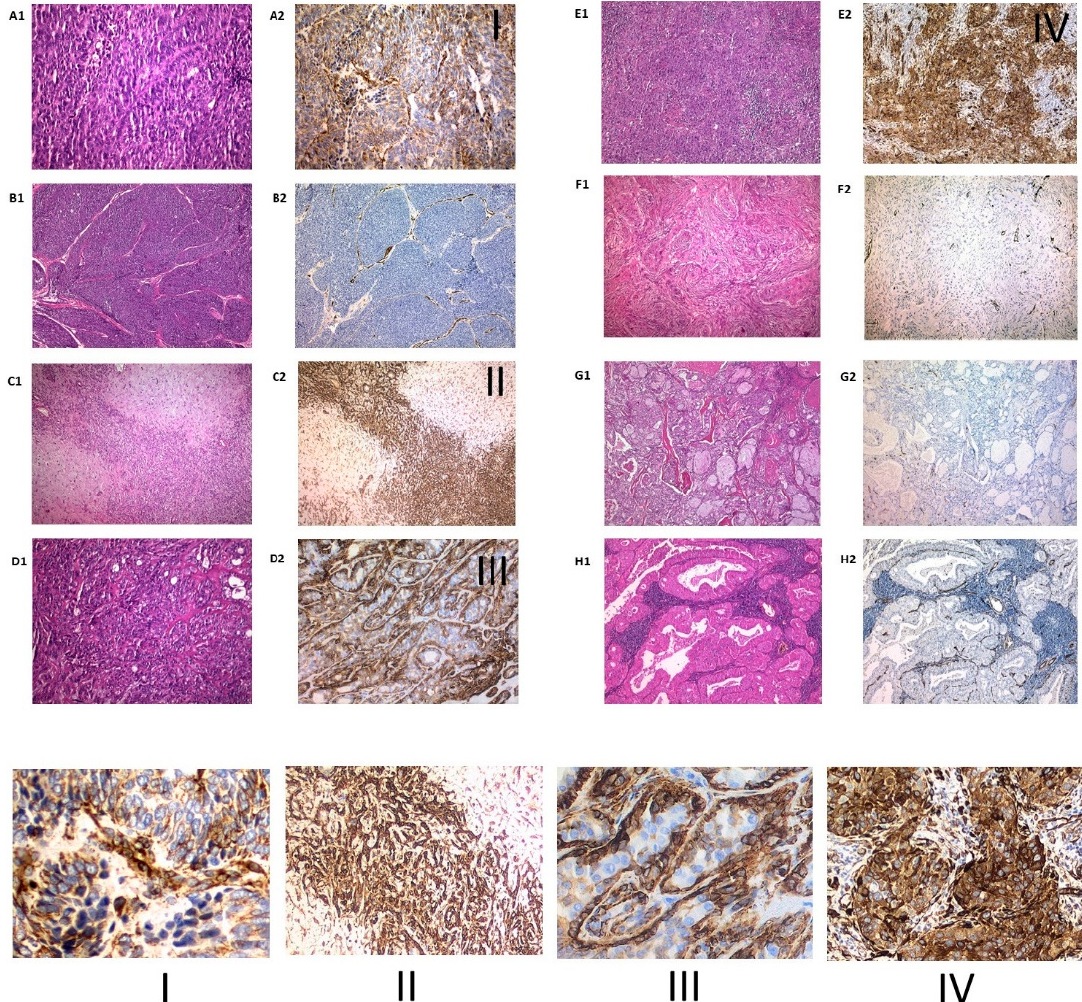
Figure 2. Two examples of poorly differentiated adenocarcinoma, one with extensive immunohistochemical staining ( A1 and A2 ) and another with no nestin expression ( B1 and B2 ). Pleomorphic adenomas ( C1 and C2 ) showed marked and widespread staining for nestin both in the epithelial and mesenchymal components in all cases. In adenoid cystic carcinomas ( D1 ) nestin expression was limited to basal cells ( D2 ). Squamous cell carcinomas demonstrated a wide range of immunohistochemical staining with some cases strongly positive ( E1 and E2 ) while others were almost completely negative ( F1 and F2 ). Finally, mucoepidermoid carcinomas ( G1 and G2 ) and Whartin ( H1 and H2 ) tumor were always negative. From I to IV, an inset with higher magnification of adenocarcinoma ( I ), pleomorphic adenoma ( II ), adenoid cystic carcinoma ( III ) and squamous cell carcinoma ( IV ).